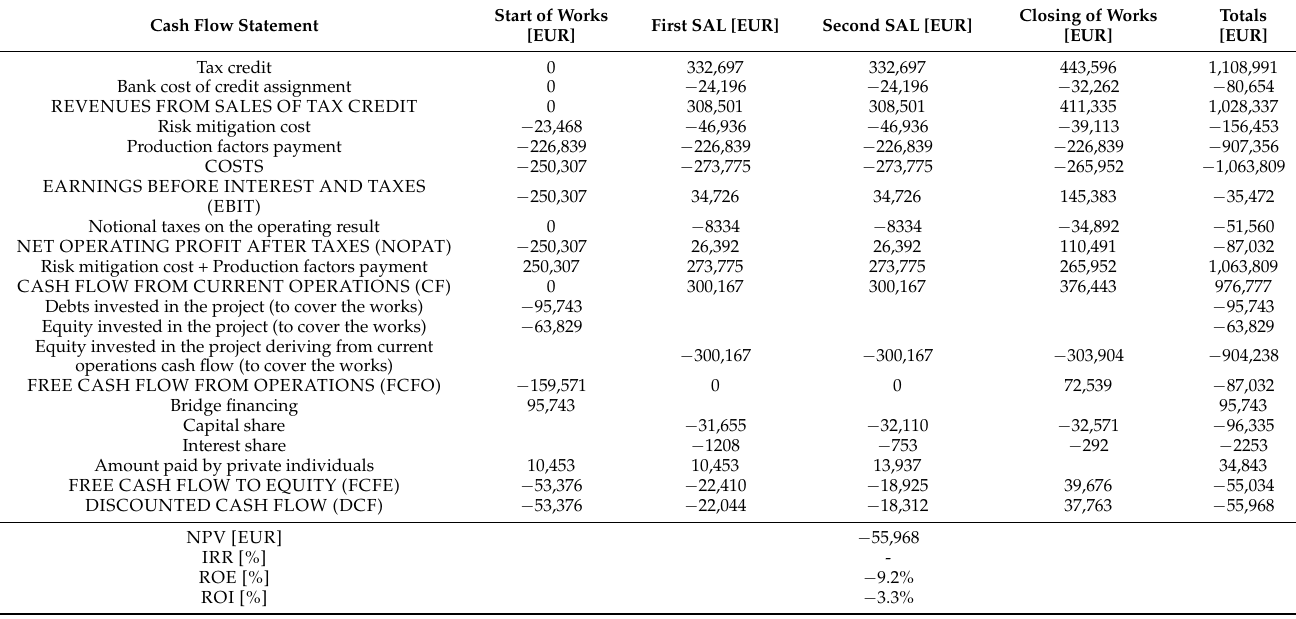
Table 10. Cash flow statement of the project in case we consider the levels of criticality associated with multi-family construction before the introduction of CILAS (most likely cost of mitigation of